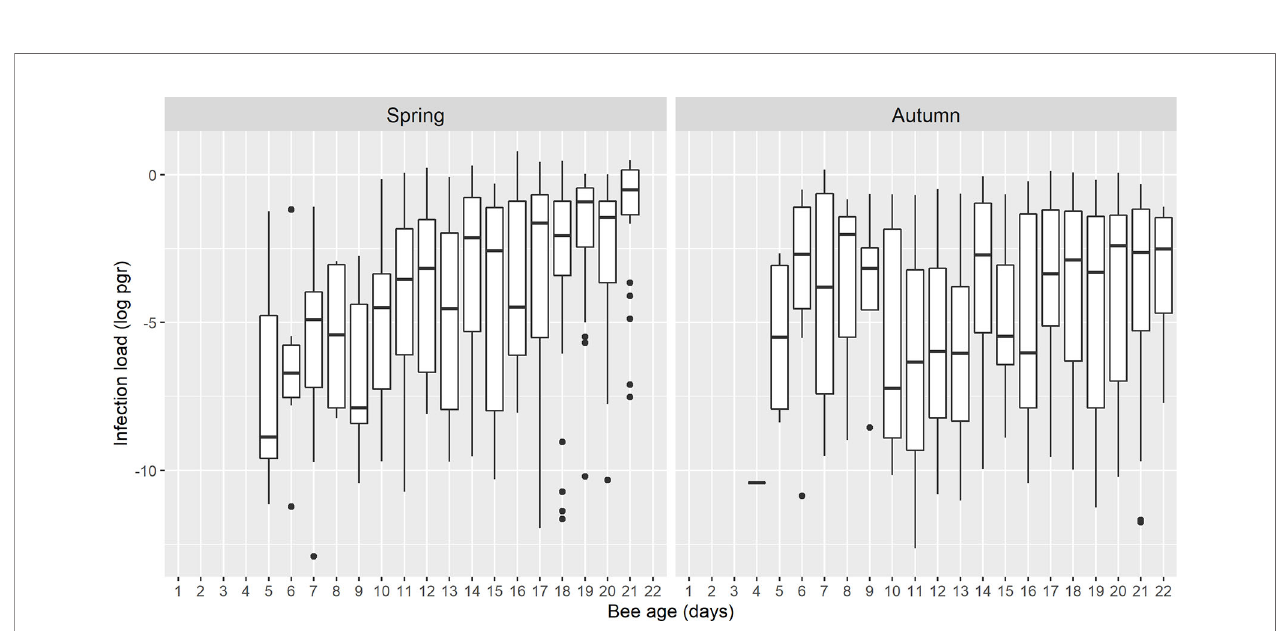
FIGURE 4 | Boxplots showing the N. ceranae - PTP3 load of picograms in logarithmic scale (log pgr) of the infected bees on each day in spring and autumn. The line represents the median while the box represents the 50% of the observations and the whiskers reach the 1.5 x interquartile range. Outliers are also shown as dots.